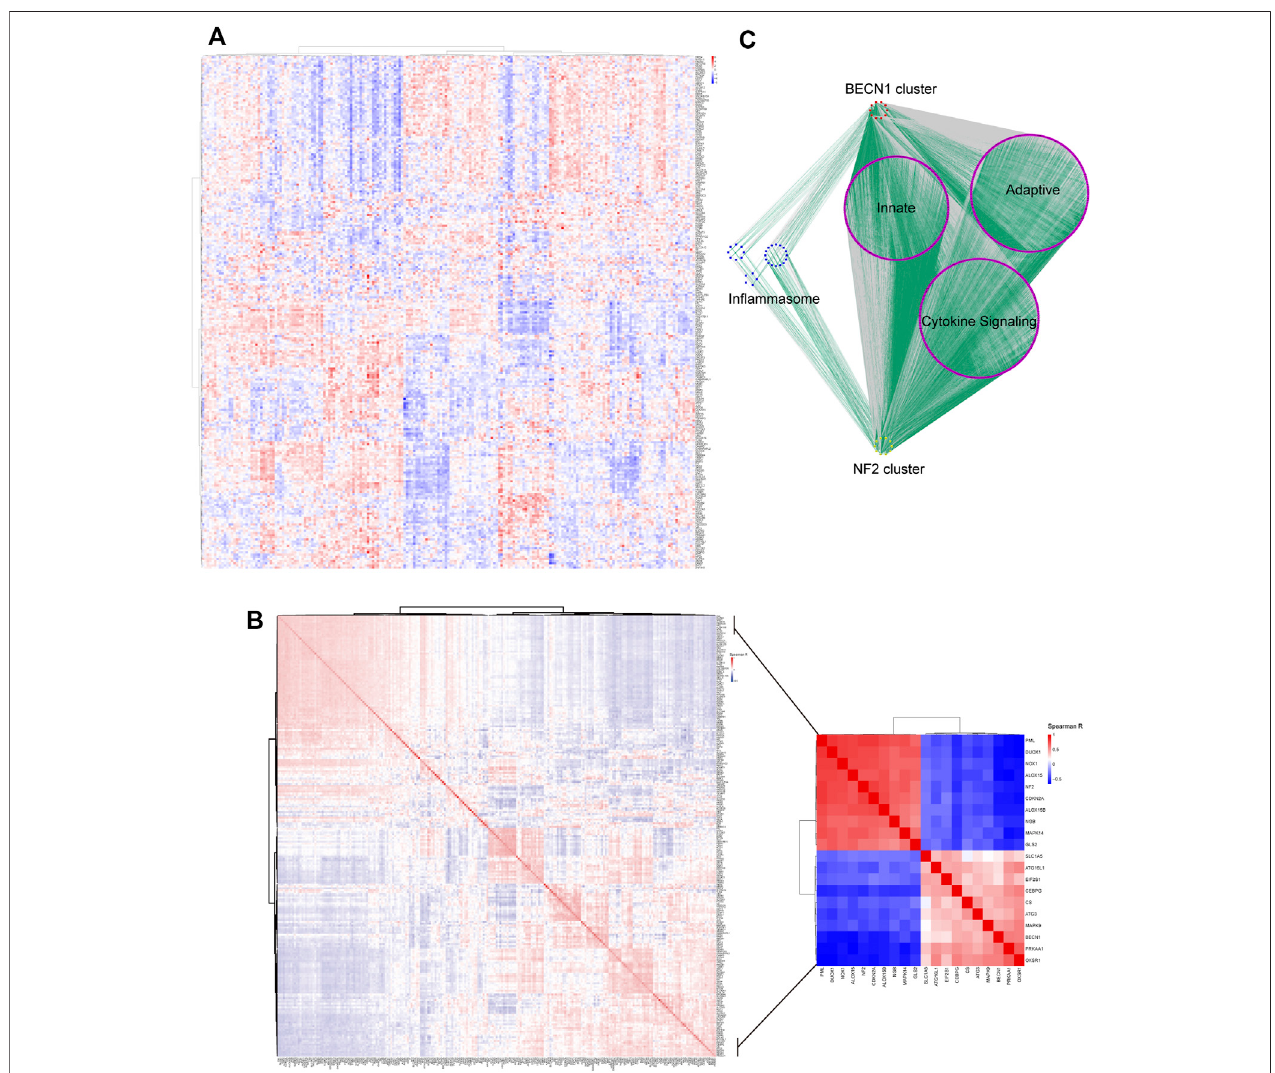
FIGURE 4| Two major clusters were identi fi ed in heterogeneously expressed FRGs. (A) Heatmap showing heterogeneously expressed FRGs acrossIRI samples. Thecolorbarshowedtheexpressionlevelofgenes. (B) Spearmancorrelationanalysisrevealedtwomajorclusterswithgenesinoneclusteroppositetotheothercluster. The inset displayed the top 10 correlated genes in each cluster. The color bar showed the range of spearman correlation r. (C) Co-expression analysis of the top 10 correlated genes in each cluster with genes involved in in fl ammasome and immune pathways. Gray lines indicated negative correlation while green lines indicated positive correlation between